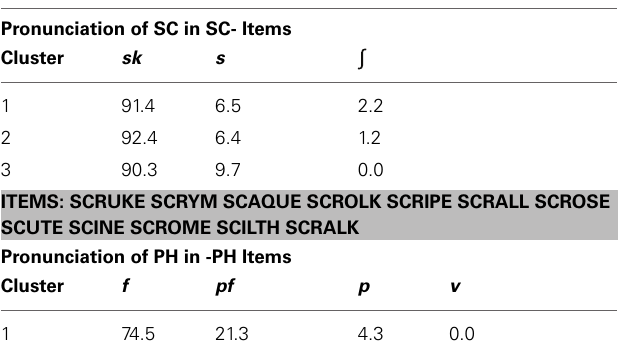
Table 2 | Pronunciation of other ambiguous consonant clusters that might be thought to distinguish clusters 1 and 2, but do not.